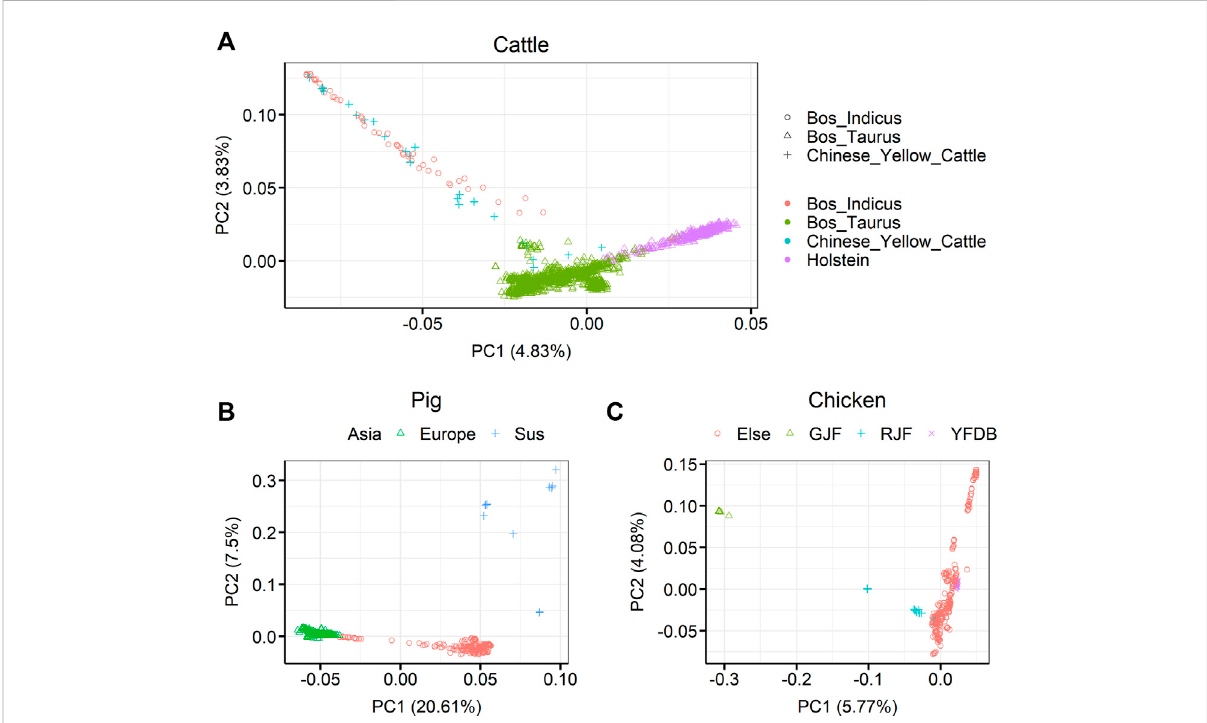
FIGURE 2 Principalcomponentanalysis(PCA)showingthepopulationstructureofthethreefarmanimals(cattle,pigs,andchickens). (A) PCAshowingthe population structure of 1,682 sequenced cattle in the RUN5 of the 1000 bull genome project. (B) PCA showing the population structure of 409 sequenced pigs in genome variation map database (C) PCA showing the population structure of 335 sequenced chickens. GJF, green jungle fowl; RJF, red jungle fowl; YFDB, yellow feather dwarf broiler. Different colors and symbols represent different